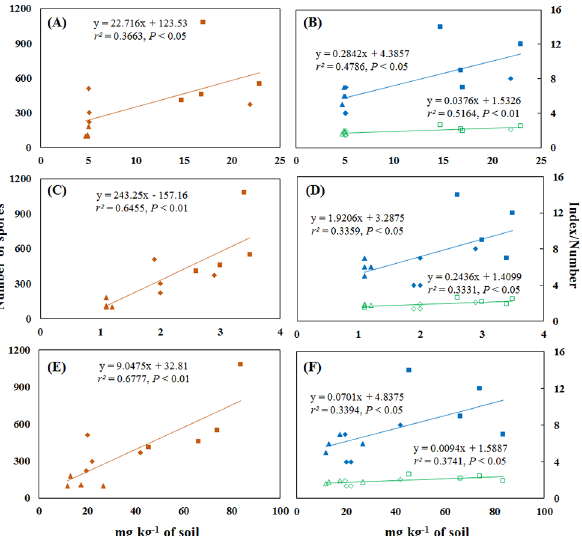
Fig 5. Regression analysis of soil As (A, B), Cd (C, D) and Zn (E, F) against Glomeraceae spore count (A, C, E), richness and diversity (B, D, F). Square, diamond and triangle represents site 1, site 2 and site 3 respectively. In Fig 5 B,D and F the open data series represents the diversity index and the closed ones are represents the